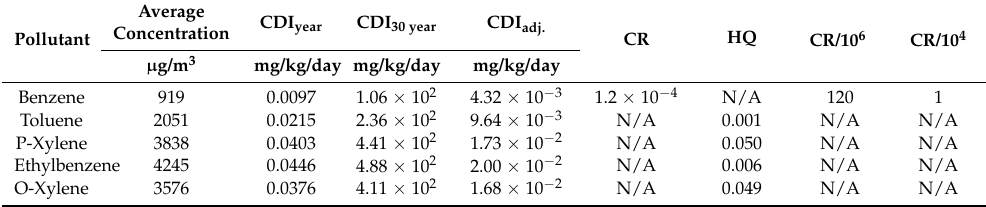
Table 5. Carcinogenic and non-carcinogenic risks for adult